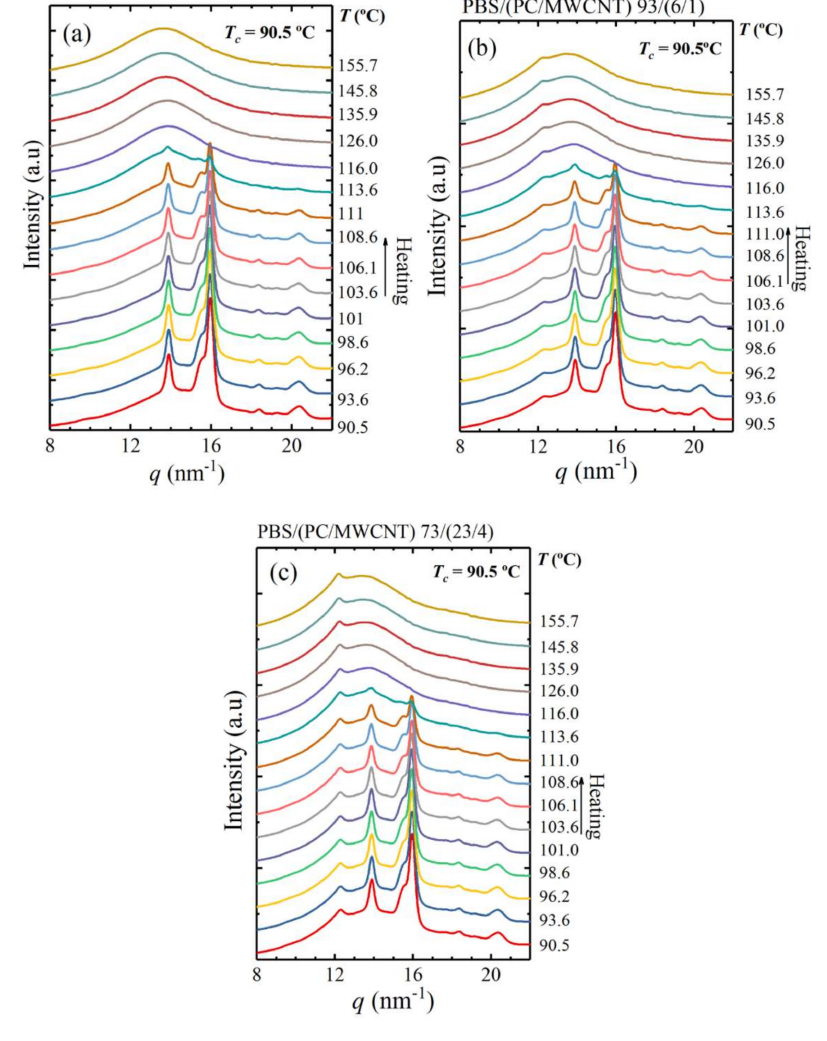
Figure 3. WAXS patterns taken during heating at 5 ◦ C min − 1 after the isothermal step at 90.5 ◦ C for ( a ) neat PBS, ( b ) PBS/(PC/MWCNTs) (93/6/1), and ( c ) PB/(PC/MWCNTs)